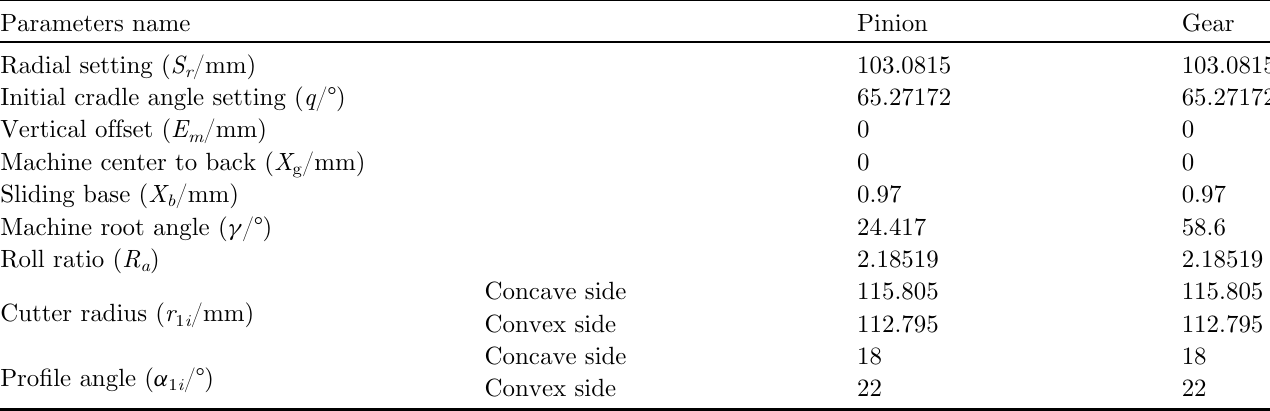
Table 2. Machine setting parameters.